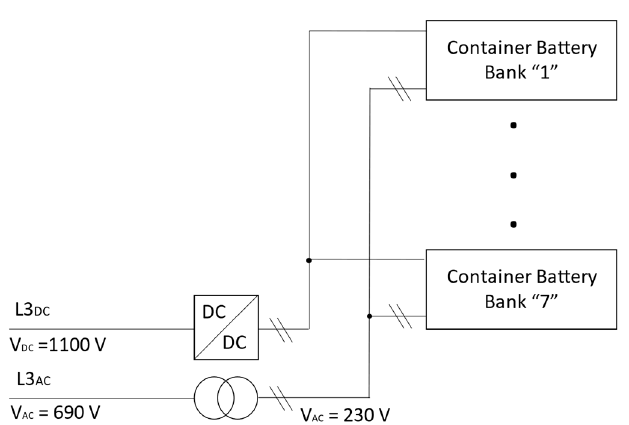
Figure 7. The topology of the connection between container energy storage elements and the onboard grid.